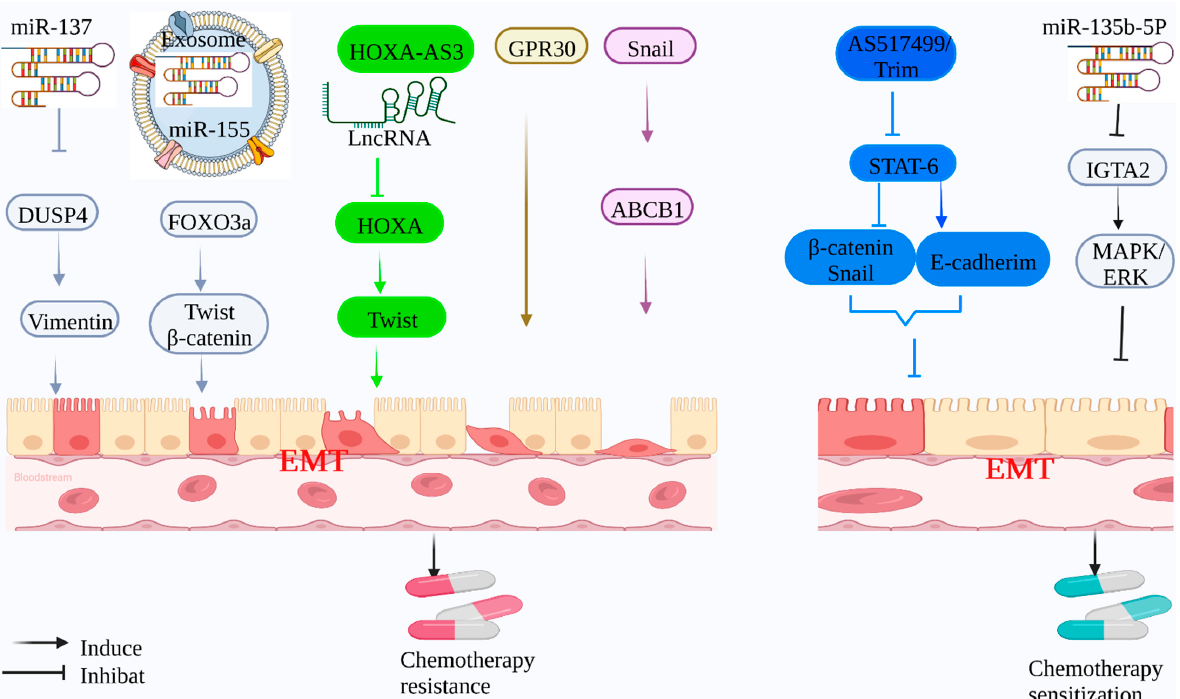
Figure 1. Mechanism of EMT-mediated chemotherapy resistance: Tumor-associated genes can induce EMT to mediate chemotherapy resistance of tumor cells. Mir-137 can inhibit the expression of target protein DUSP4 and induce EMT, which activates vimentin; exosomal Mir-155 can target the expression of FOXO3a and up-regulate the expression of β -catenin and Twist; lncRNA HOXA-AS3 can inhibit the expression of HOXA3 and up-regulate the expression of Twist, as well as participating in mediating adriamycin and cisplatin drug resistance; tumor-associated protein GPR30 can induce EMT and mediate cisplatin resistance. The tumor-related protein Snail regulates ABCB1 expression, induces EMT, and mediates 5-FU resistance. At the same time, 5-FU combined with AS1517499 and Trim inhibited the phosphorylation of STAT-6, up-regulated the expression of E-cadherin, and down-regulated the expression of Snail and β -catenin, delaying the progression of EMT, and enhanced the sensitivity of 5-FU to EMT-mediated chemotherapy resistance. Mir-135b-5p can target the expression of IGTA2, down-regulate the MAPK/ERK signaling pathway, delay the progression of EMT, and enhance the sensitivity of 5-FU.